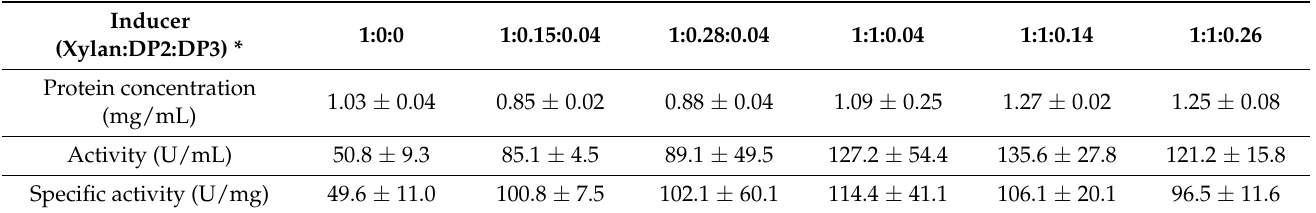
Table 2. Concentration and activity of extracellular proteins induced by B. halodurans with xylan and xylo-oligosaccharides (DP2 and DP3).